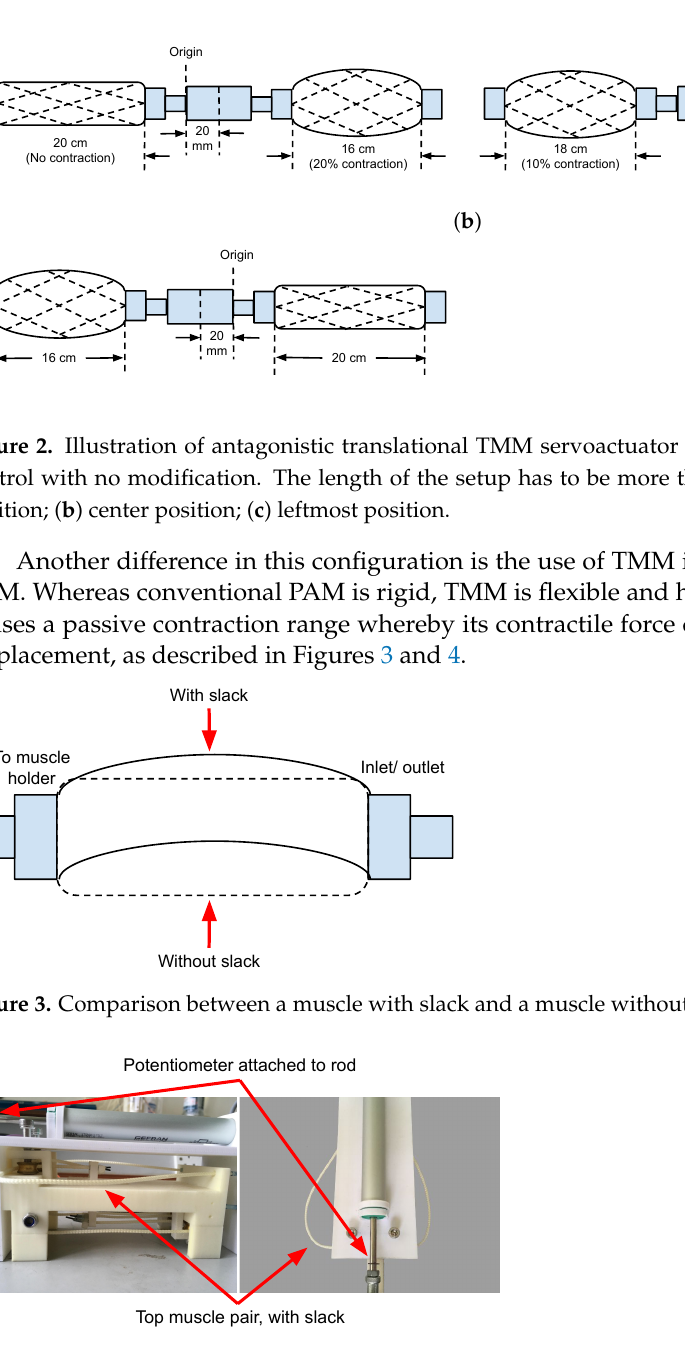
Figure 4. Top muscle pair with slack and passive